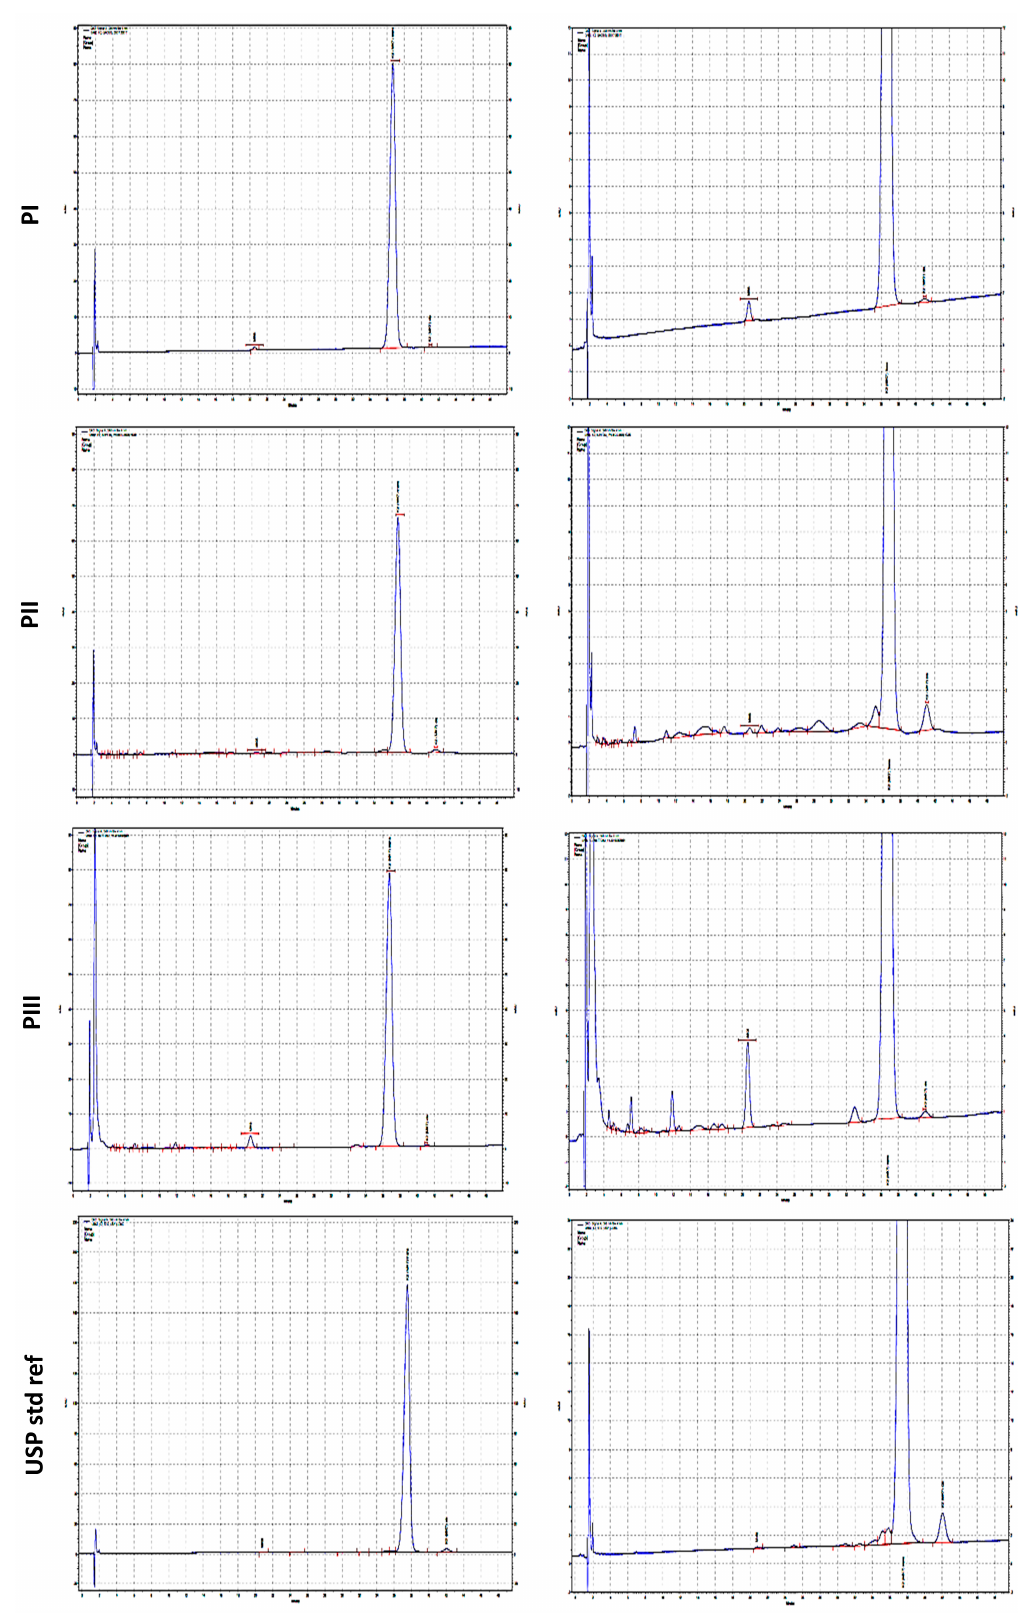
Figure 3. Chromatographic purity profile of commercially available MK7 products, either from fermentation PI (Gnosis) and PIII (Sungen Bioscience) or from chemical synthesis PII (Kappa Biosciences). The USP reference standard is also included. Right panel is a magnification of chromatographic profile highlighting the presence of